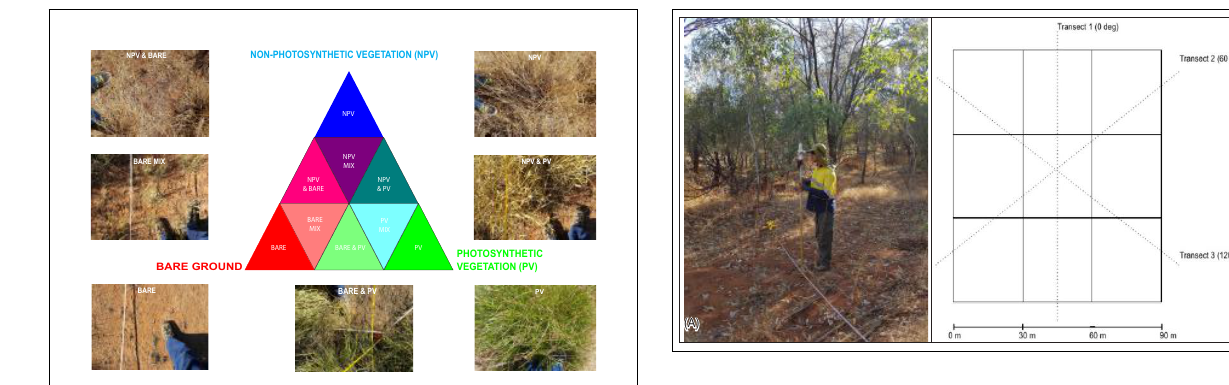
Figure 5. (A) Example of point intercept field collection